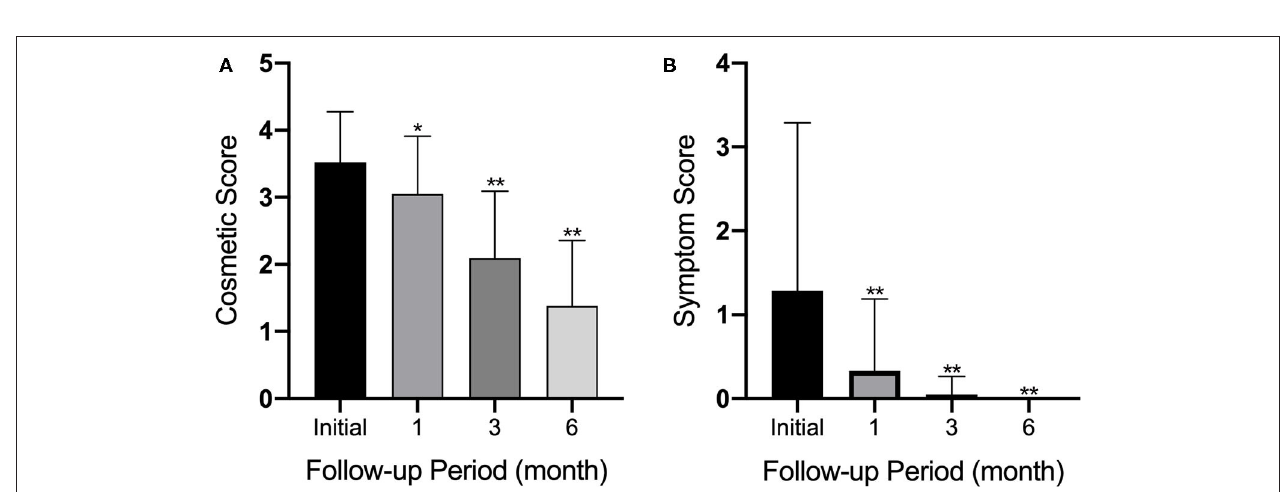
FIGURE 3 | Graphs show mean thyroid nodule volume change during follow-up (FU) and individual nodule volumes. Error bars = standard deviation; * p < 0.05.